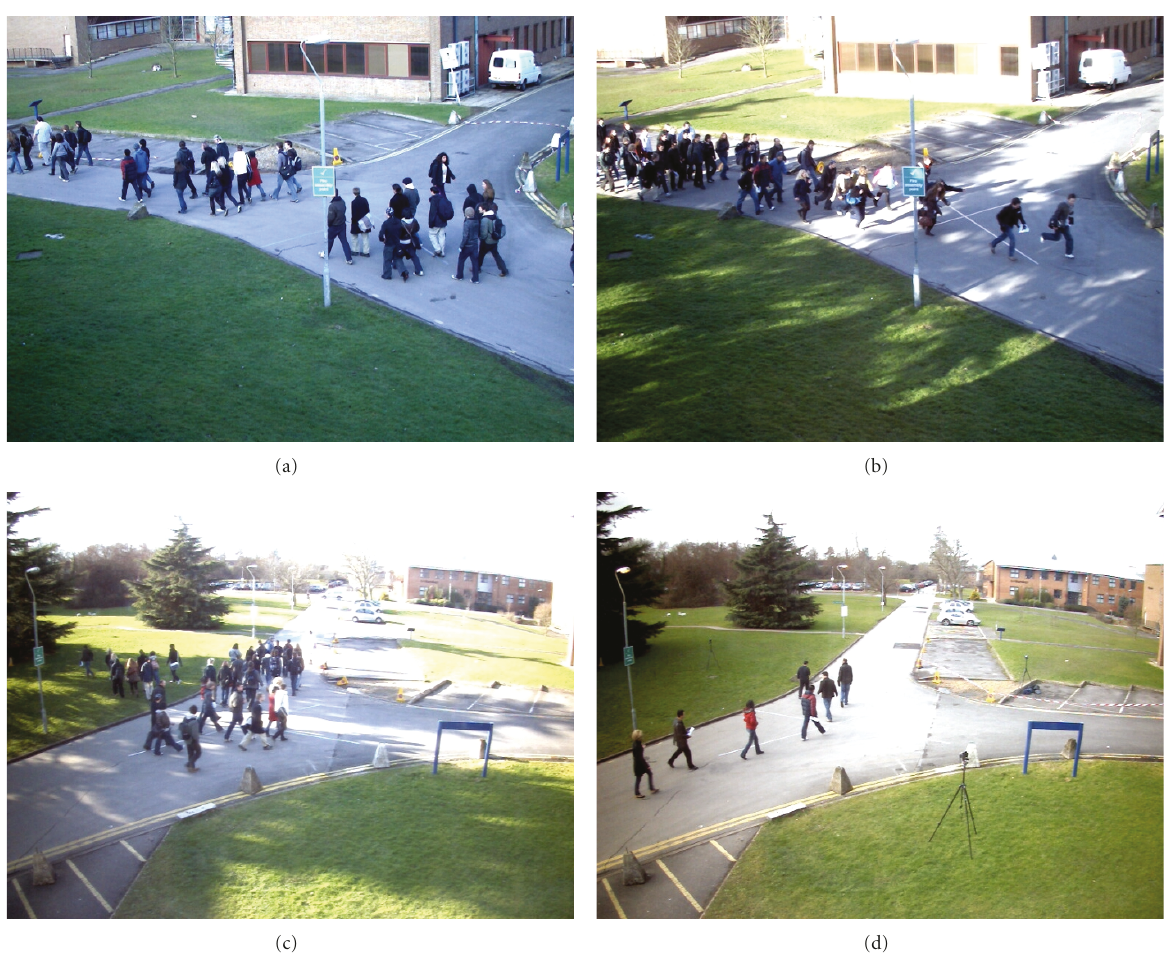
Figure 5: Examples of the frames of the video sequences used for the test: (a) S1.L1.13-57 (view 1), (b) S1.L3.14-17 (view 1), (c) S1.L2.14-31 (view 2), and (d) S3.MF.12-43 (view 2).